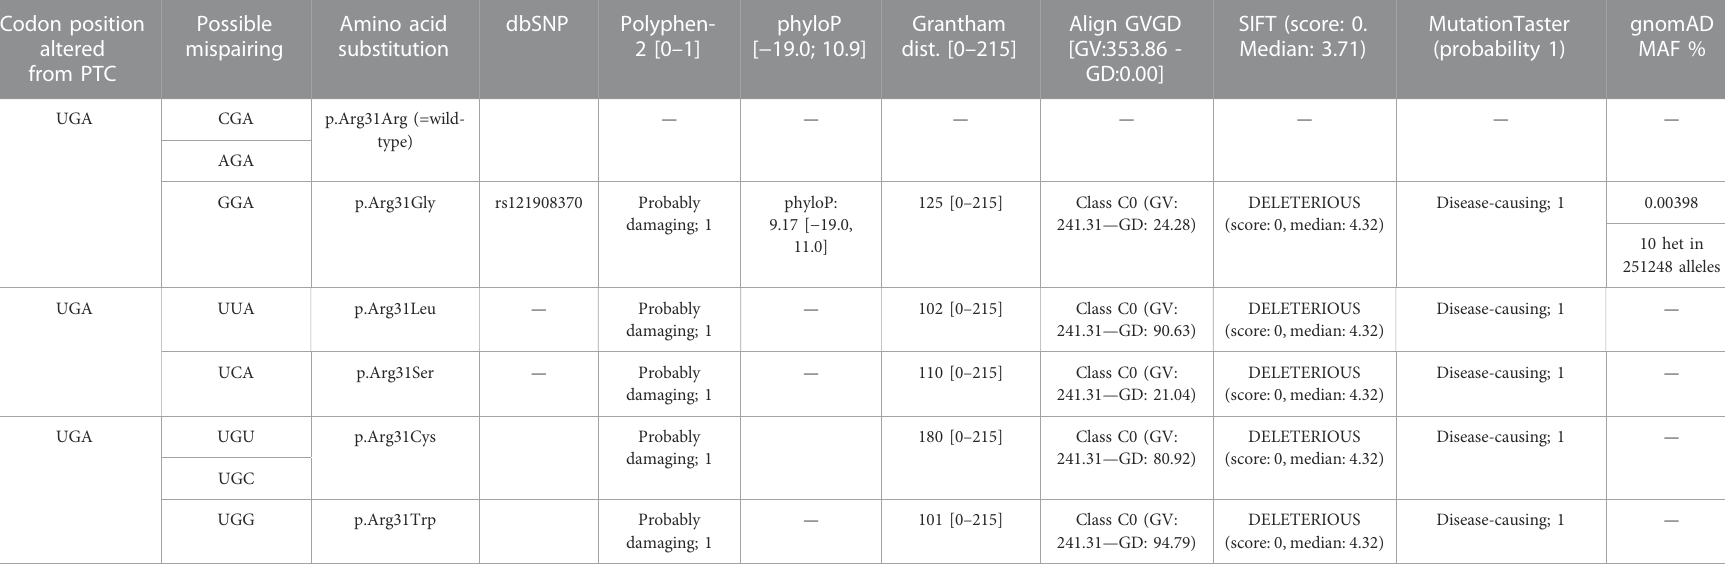
TABLE 1 In silico missense variant assessment on potential disease-association of the predicted amino acid substitions resulting from translational read-through of USH1C c.91C > T; p.R31* nonsense mutation (i.e., wild-type codon - “ -CGA- ” to mutant premature termination codon “ -TGA- ” ). Codon position altered from